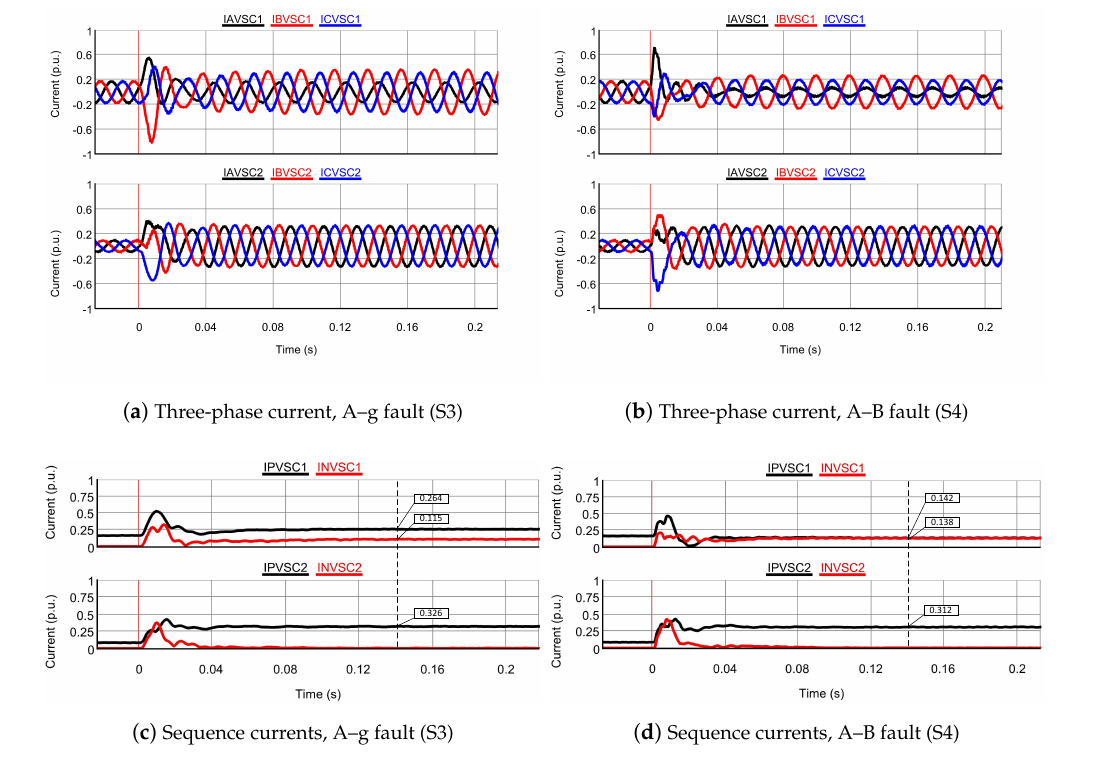
Figure 7. VSC short circuit current (measured from the delta winding side) from the RTDS simulation of a fault at bus 4. (IP: positive-sequence current; IN: negative-sequence current). By comparing the results from S1 with S4, it can be seen that changes in sequence active powers ( P + , P − ) do not alter the retained grid voltages notably. However, when comparing S1, S2 and S3, it can be observed that changes in sequence reactive powers ( Q + , Q − ) have more effects on the retained voltages. This is reasonable since the voltages of an inductive grid are mainly regulated by reactive power. Different control strategies could yield different values for factor c , hence changing the combination of Q + and Q −